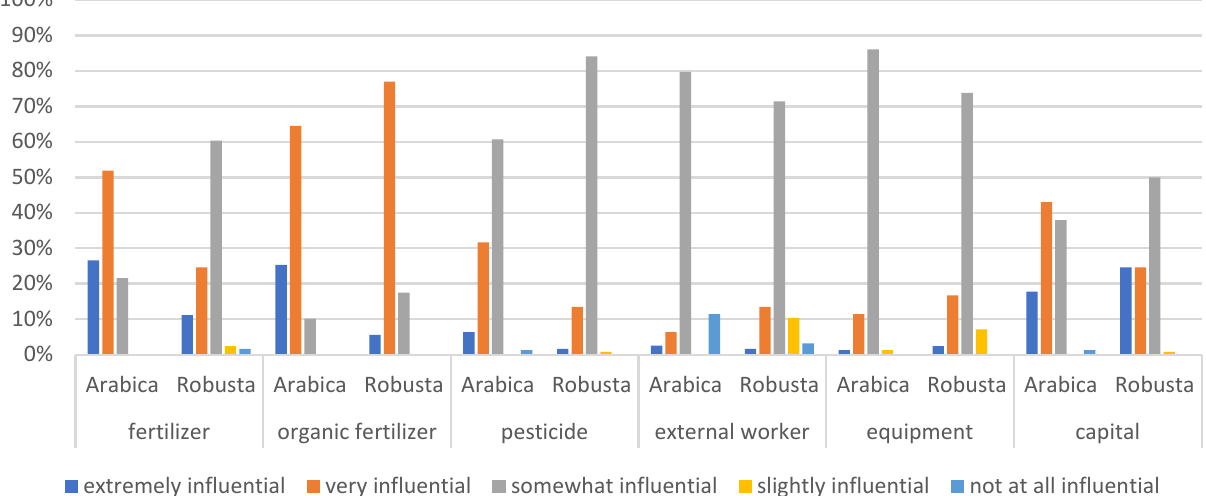
Figure 3. The proportion of coffee farmers who experienced affects in the farming input aspect as a result of COVID-19.